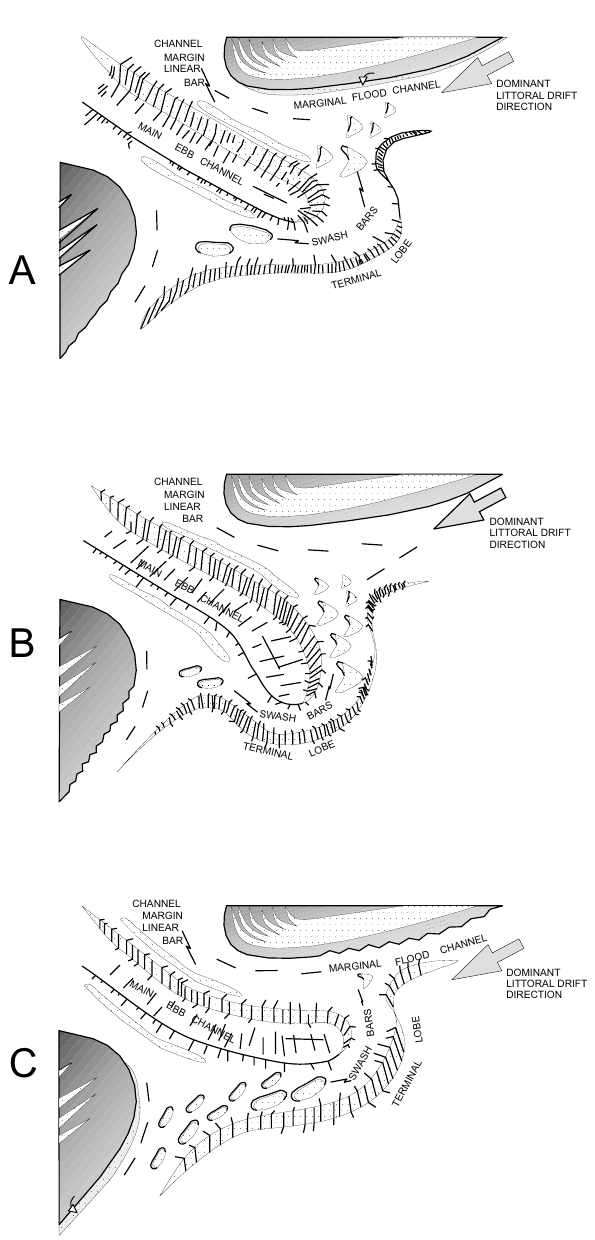
Fig. 7 – Schematic model of the morphology of an ebb tidal delta and changes in the orientation of the main channel due to the littoral drift and sediment bypass. A) sediment entrapment and growth of sand bars in the ufpdrift side favors progradation and starts erosion in the downdrift side; B) intense erosion occurs in the downdrift side due to the long-lasting entrapment of sand in the updrift side, which forces the channel to be steered to the south and interrupts progradation in the updrif side; C) the channel breaches through the northern side of the delta lobe and sediment is bypassed to the downdrift side, which starts a new progradational cycle. Erosion starts to occur in the updrift side until new sand bars are formed and more sediment is captured (modified of Hayes